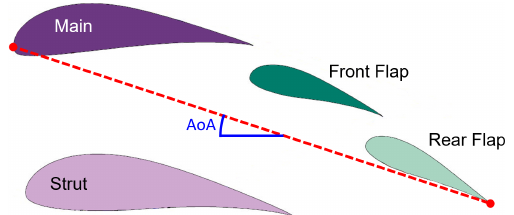
Figure 2. MFFS-018 multi-element airfoil baseline geometry (Ragheb and Selig,